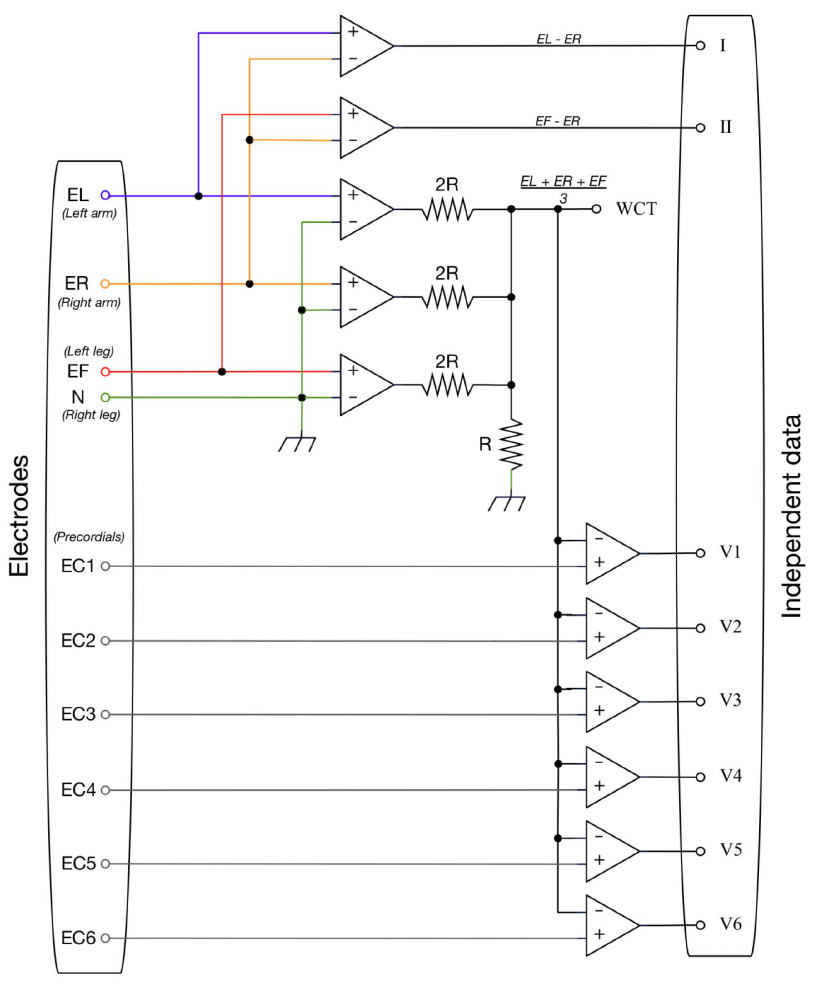
Figure 1. Generalized functional diagram for a typical 12-lead ECG system.